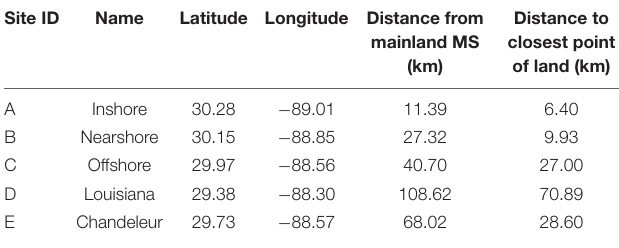
TABLE 1 | Location of carcass and effigy